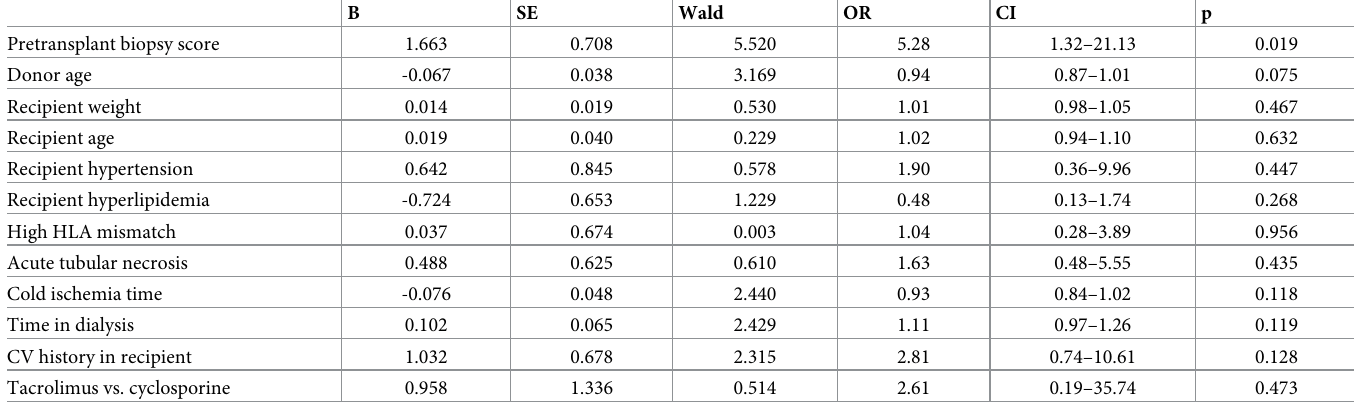
Table 5. Multivariate logistic regression analysis for the association of pretransplant biopsy score with acute